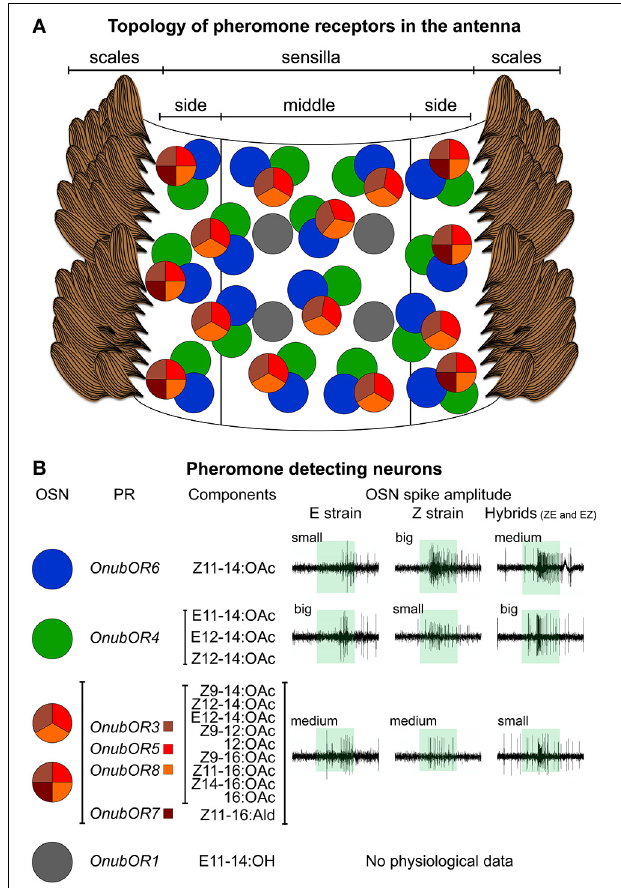
FIGURE 2 | Schematic representation illustrating the in situ hybridization and SSR results. (A) topography of different sensilla types and OnubOR -expressing neurons in a typical O. nubilalis male antenna segment. Three of the OSNs that express OnubORs (green, blue, and red) co-localize in the same type of sensillum, whereas one OSN ( OnubOR1 , gray) is housed in a separate sensillum type. Two OSN sub-types are found, expressing three (medial sensilla, OnubOR7 missing) or four OnubORs (lateral sensilla, including OnubOR7 ). (B) Pheromone sensory neuron types, the OnubOR genes they express, compounds stimulating them and sample physiological recording traces.